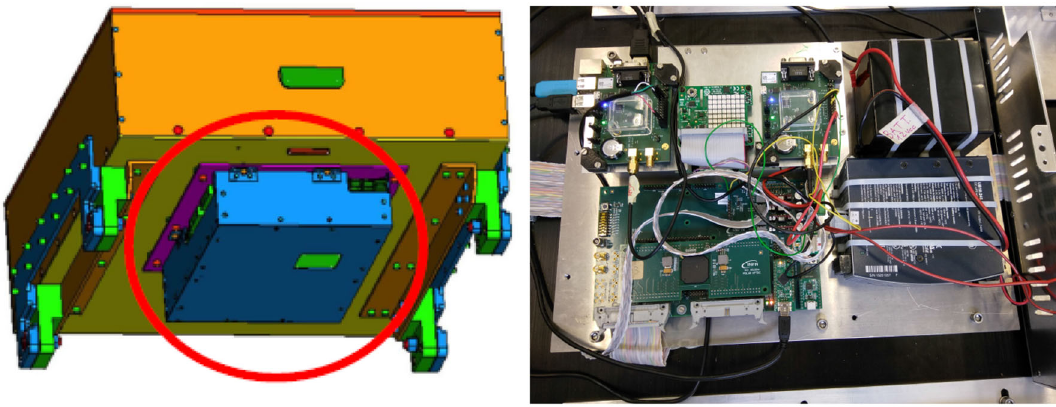
Fig. 3 Left panel: artist view of the detector box, with the electronics box at the bottom (highlighted with a red circle). Right panel: electronics box with the TRB, the power supply, the RPi3, the Sense Hat and the EVK-M8xZOE GLONASS board